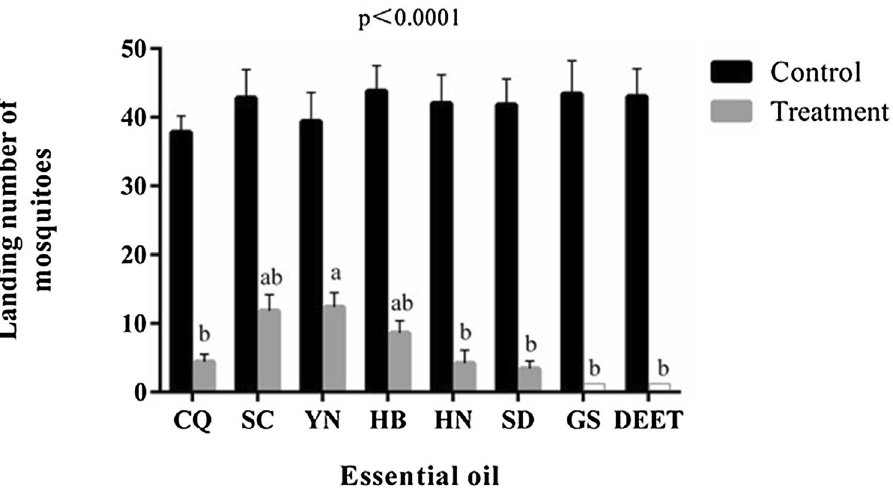
Figure 1. The first 5-min observed landing rates of starved An. sinensis on human skins treated with seven Ar. argyi essential oils extracted from different geographical areas. The significances between each treatment and control group are less than 0.0001 (p < 0.0001). Different letters on each treatment bars indicate significantly different between among the seven essential oils tested and the positive control, DEET (ANOVA).